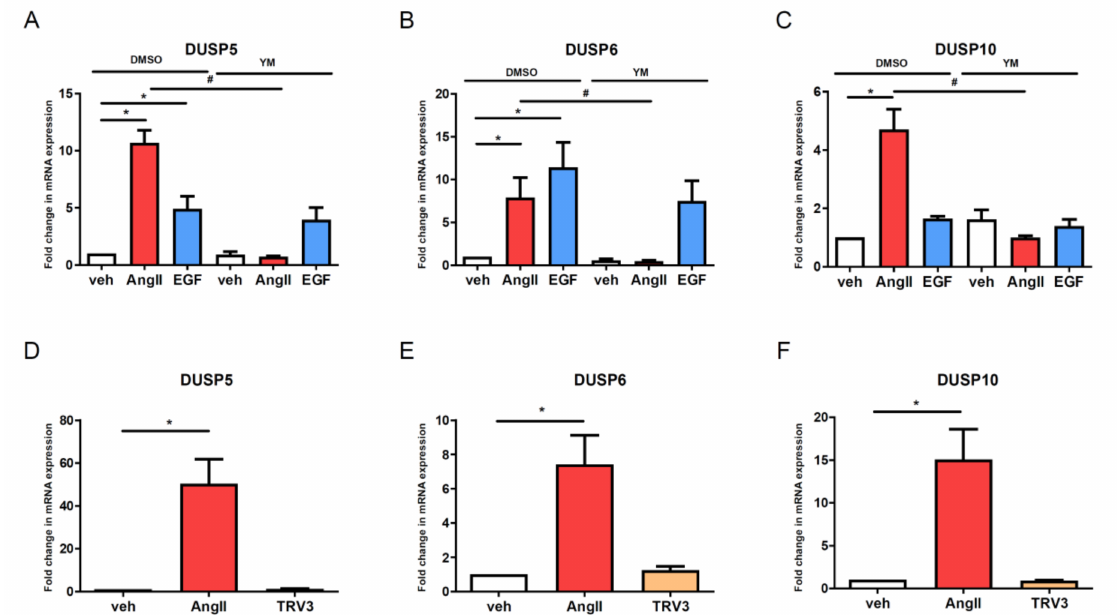
Figure 4. Evaluation of the contribution of G-protein-dependent and independent mechanisms in the AT 1 -receptor stimulation on induced changes in DUSP levels in vascular smooth muscle cells. Serum-depleted VSMCs were incubated with 1 µ M YM-254890 (YM) or DMSO as a control for 30 min, then the cells were exposed to either 100 nM AngII (red columns) or 50 ng/mL EGF (blue columns) or vehicle (white columns) for 2 h ( A – C ). The serum-starved VSMCs were exposed to either the vehicle (white columns) or 100 nM AngII I (red columns) or 3 µ M TRV120023 (beige columns) for 2 h ( D – F ). RNA was isolated from VSMCs, then converted to cDNA. cDNA levels of DUSP5 ( A , D ), DUSP6 ( B , E ) and DUSP10 ( C , F ) were measured by qRT-PCR. Standardization was established against the GAPDH housekeeping gene. Mean values ± SE are shown. Significance was determined via multiple linear regressions. p < 0.05 was considered as statistically significant. *: statistically significant from vehicle stimulation. #: statistically significant from DMSO pretreated agonist-induced response ( A – C ). In the case of D – F, significance was determined with a one-way ANOVA-test (* p < 0.05). The values are from four or five independent experiments ( n =